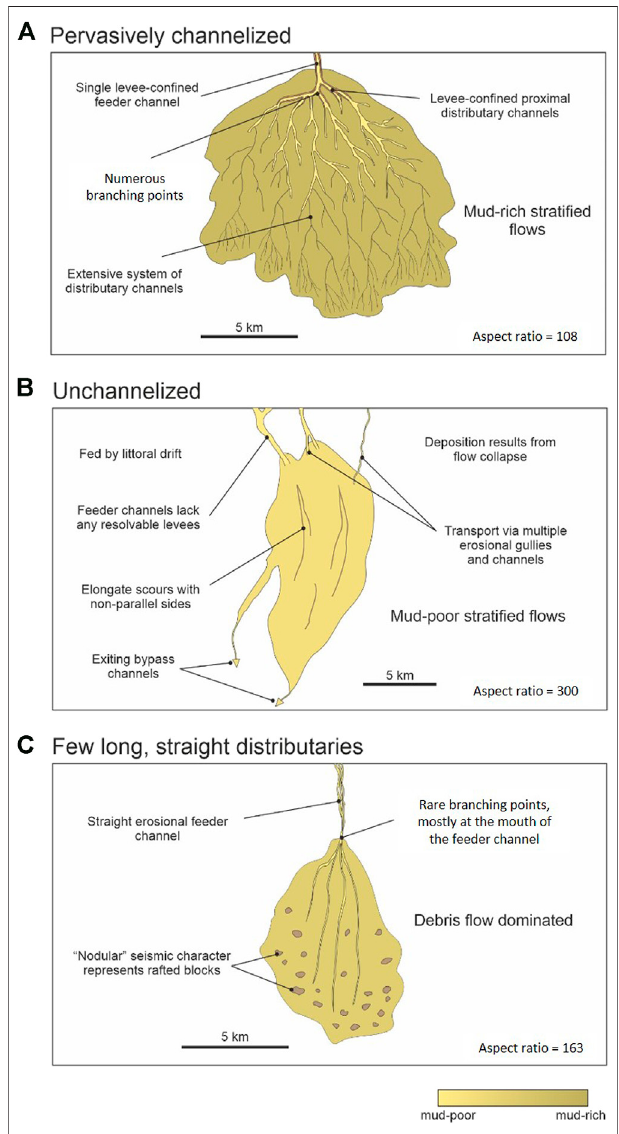
FIGURE 11 | Generalized illustrations of the three models of lobate deposits proposed here emphasizing their distinctive characteristics. (A) Pervasively channelized; (B) Unchannelized; and (C) Few long, straight distributaries.